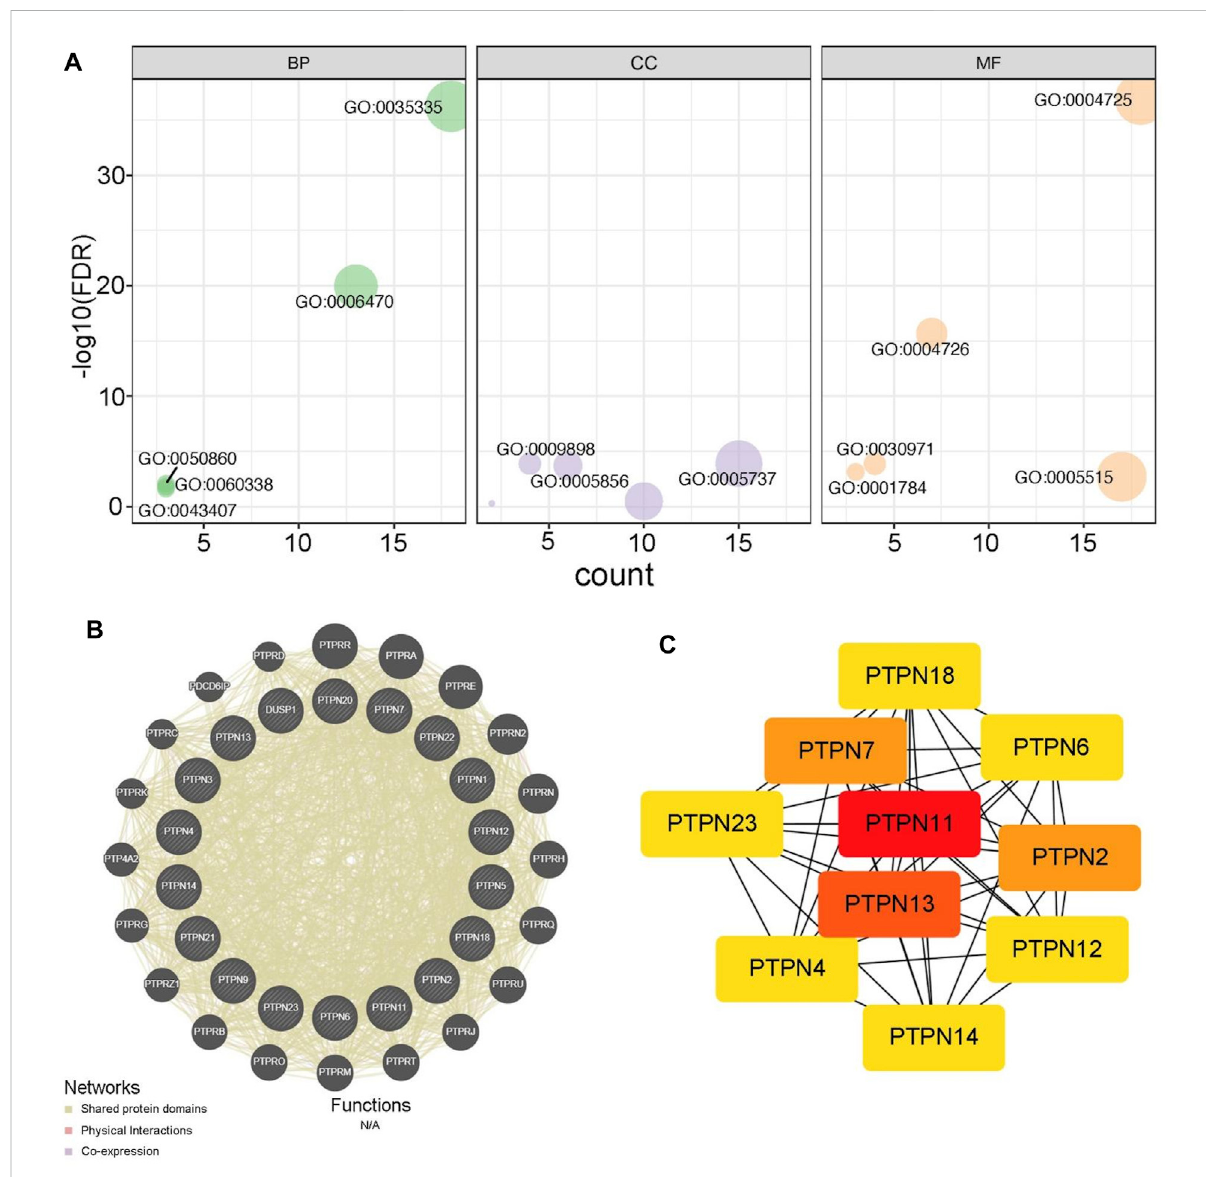
FIGURE 2 Functions of PTPNs and their interacted networks. (A) GO analysis of PTPN family based on the DAVID tool. (B) Predicted pathways of PTPNs using the GeneMANIA tool. The interconnections between proteins were explored intermsof physicalinteraction, coexpression and shared protein domains. (C) PPI network of PTPNs constructed using the STRING tool and visualized using the Cytoscape